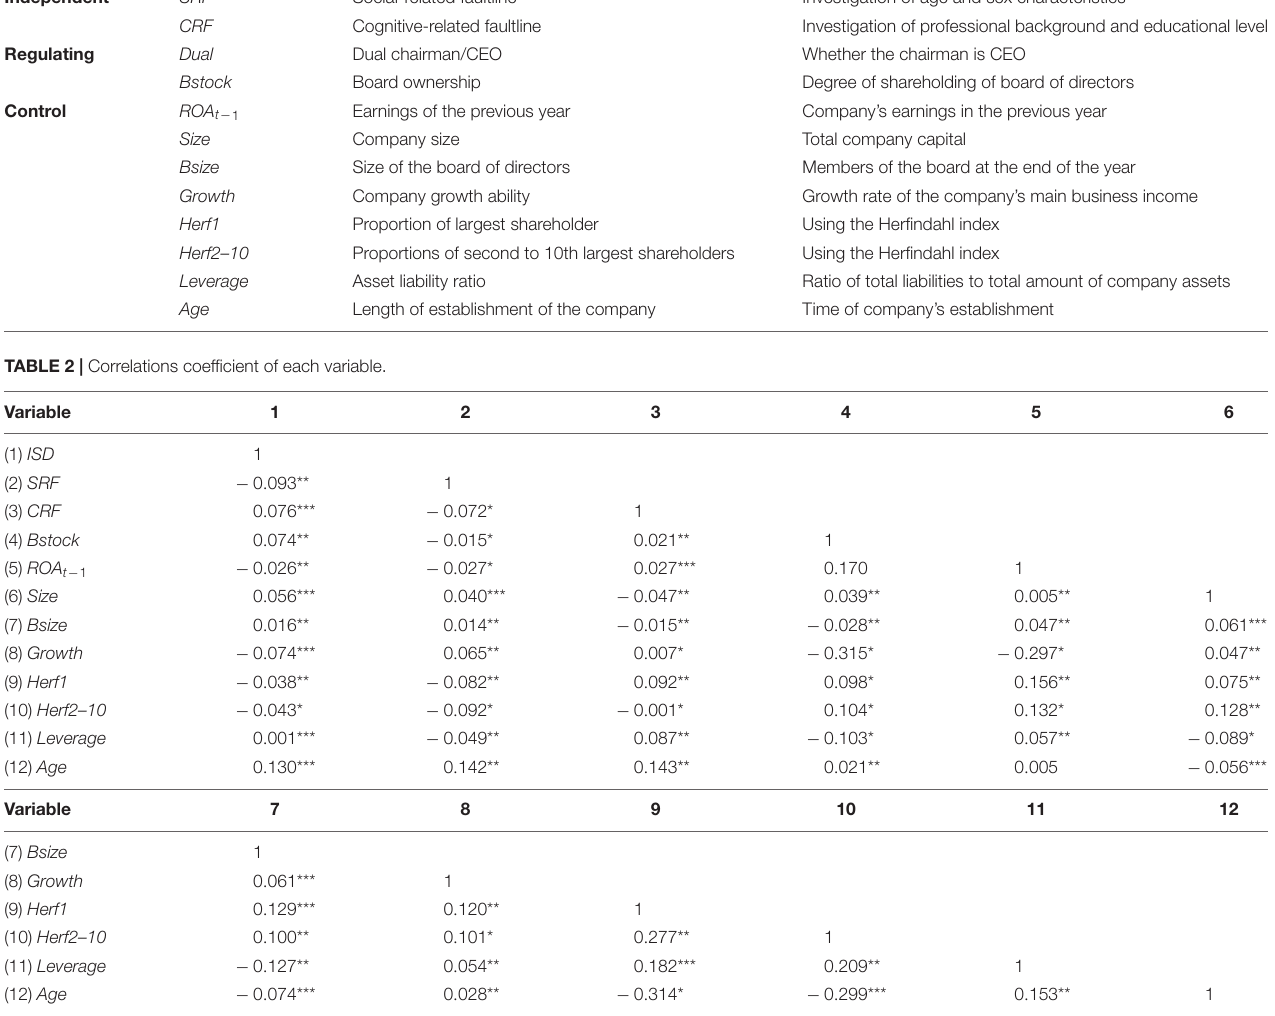
TABLE 1 | Main variables.